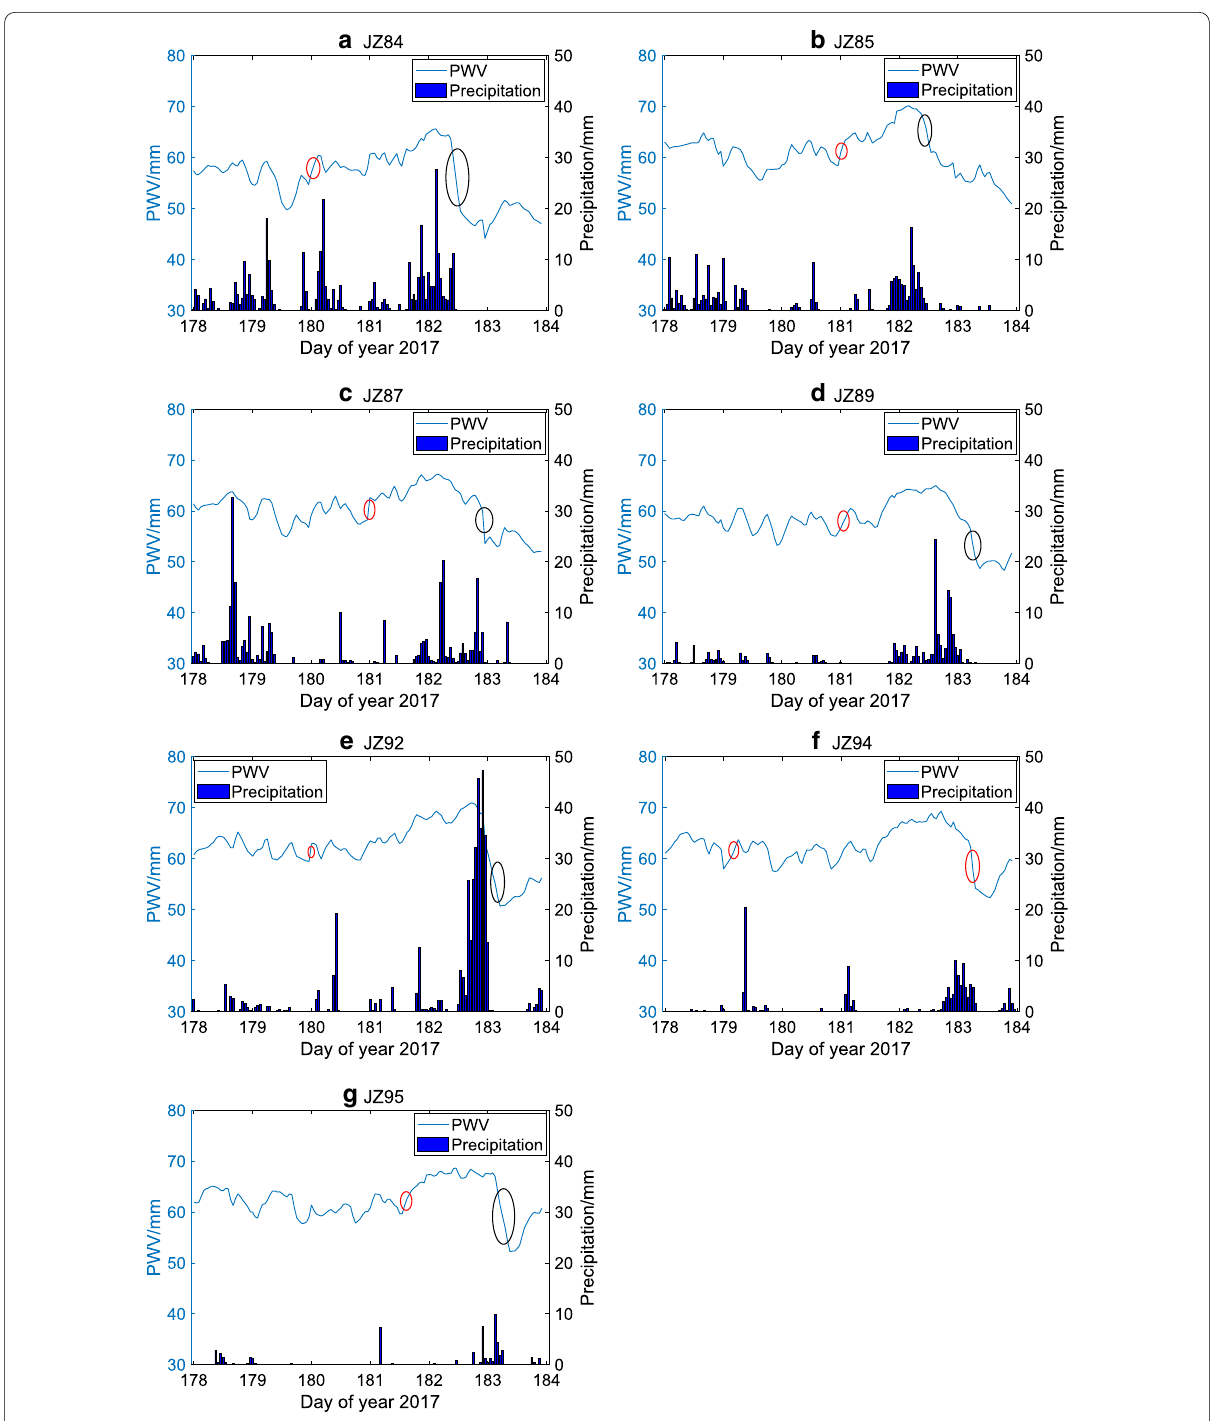
Fig. 7 Hourly PWV retrieved from seven GNSS sites and actual precipitation from 27 June to 2 July 2017 (the red circle represents PWV variation before rainfall events, and the black circle represents PWV variation after rainfall